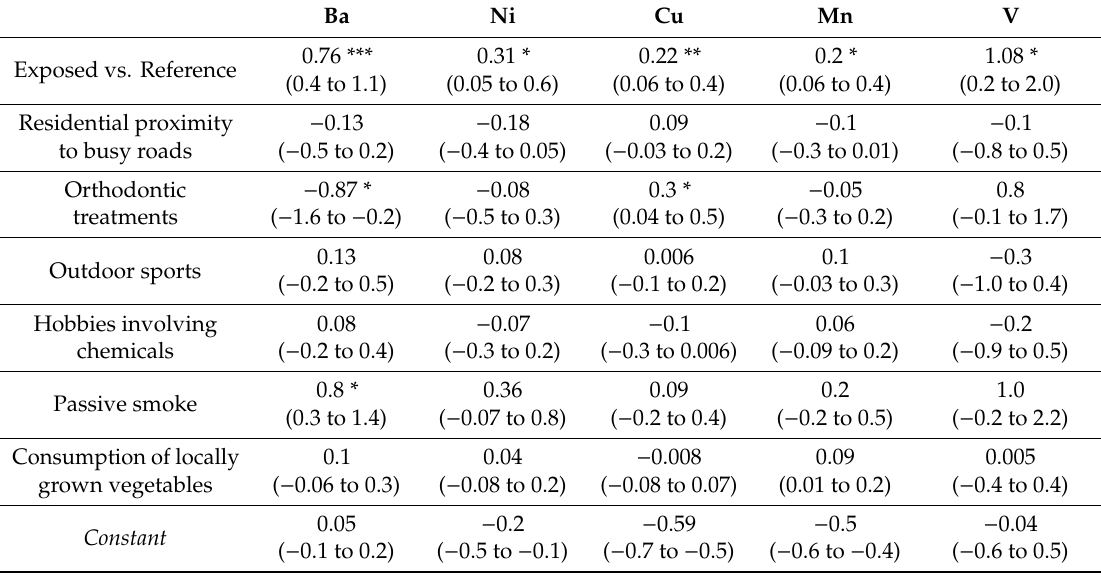
Table 2. Results of Tobit regression model on metal concentrations in toenails from children living within a 3 km radius circle around the two incinerators (exposed area) or in the reference area, and the e ff ect of covariates.